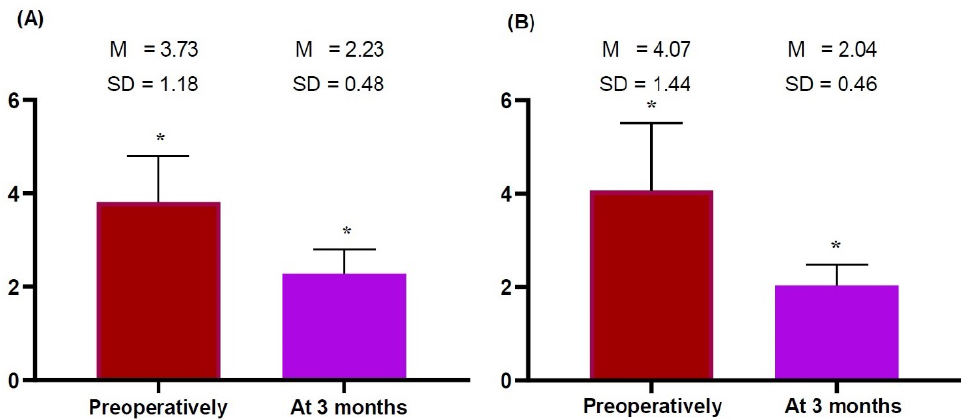
Figure 3. ( A , B ) Differences in the thickness of the pectoralis major measured on breast ultrasound preoperatively and 3 months postoperatively. Preoperatively and 3 months postoperatively, the thickness of pectoralis major was measured on both sides of the breast. This showed significant differences in the thickness of subcutaneous tissue between the preoperative and 3-months postoperative measurements (right side: 3.73 ± 1.18 vs. 2.23 ± 0.48 mm, t = 5.633, p = 0.000 and left side: 4.07 ± 1.44 vs. 2.04 ± 0.46 mm, t = 4.882, p = 0.000). Note: The y -axis indicates measurements. * Statistical significance at p < 0.05.